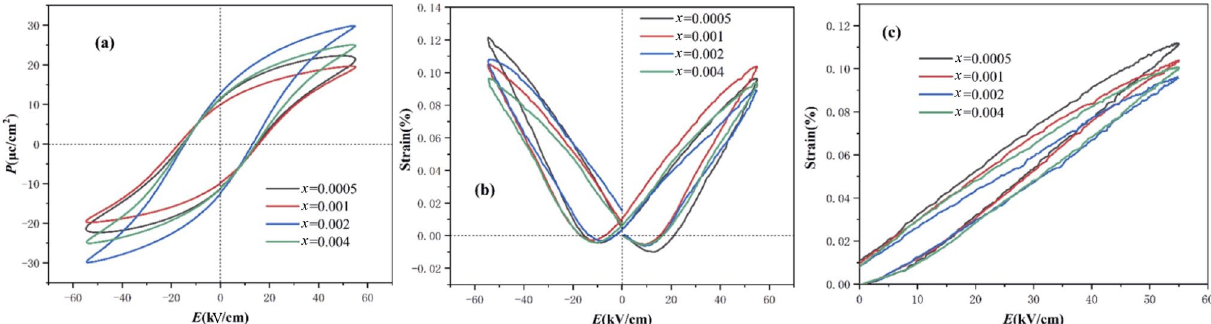
Fig. 4 (a) P – E hysteresis loops, (b) bipolar strain curves, (c) unipolar strain curves of KNNS–0.04BNKZ– x Sm ( x = 0.0005, 0.001, 0.002, and 0.004) ceramics measured at room temperature and 10